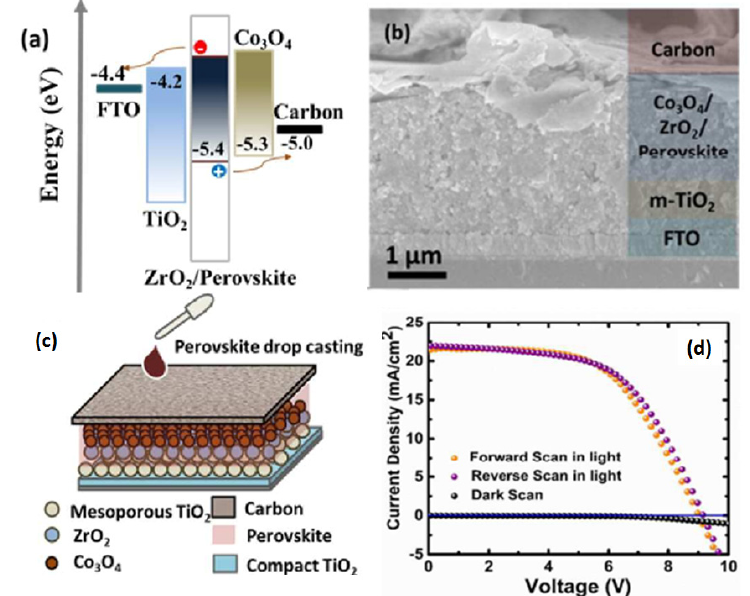
Figure 20. ( a ) Energy band diagram. ( b ) High-magnification cross-section SEM micrographs of the perovskite/carbon solar cell with cobalt oxide layer. ( c ) Schematic illustration of the device architecture. ( d ) J–V characteristics of standard carbon cell with Co 3 O 4 (Co 3 O 4 /C) layer with an active area of 70 cm 2 under 1 sun illumination [98]. (Reproduced from Ref. [98], 10.1039/C7NR08289D, with permission).